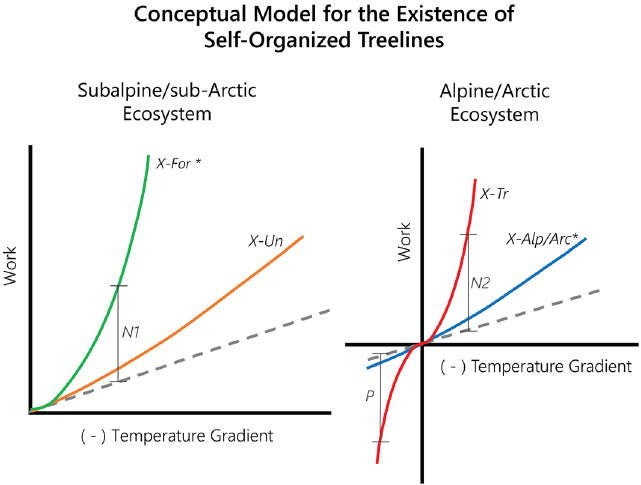
Figure 7. Conceptual model for the existence of treelines as a result of self-organization of the thermal environment. Self-organized treelines are demonstrated through the balance of positive or negative feedback between the resulting temperature gradient and the work performed by various vegetation structures. The negative of the resultant temperature gradient is plotted on the x-axis. Thus, the positive x-axis refers to a negative temperature gradient such that larger values indicate stronger declines in temperature from the earth surface to the atmosphere. The negative x-axis indicates positive temperature gradients, or temperature inversions. The dotted line represents an ecosystem without vegetation (i.e., bare soil). The colored solid lines represent vegetation curves as defined in Table 1. Dissipation rates leading to negative ( N1 or N2 ) or positive ( P ) feedback loops between temperature gradient and vegetation structure are shown as the vertical distance from the bare soil curve to the vegetation scenarios. The starred scenario on each plot represents the most advantageous viable vegetation structure for the given ecosystem. The plot on the left represents ecosystems in which both vegetation scenarios ( X-For & X-Un ) are viable options, and the X-For scenario is most advantageous. The plot on the right represents ecosystems in which one of the vegetation scenarios ( X- Tr ) is infeasible due to positive feedback loops that result in continued dissipation of heat during temperature inversions. Instead, the X-Alp/Arc scenario is the most advantageous viable vegetation